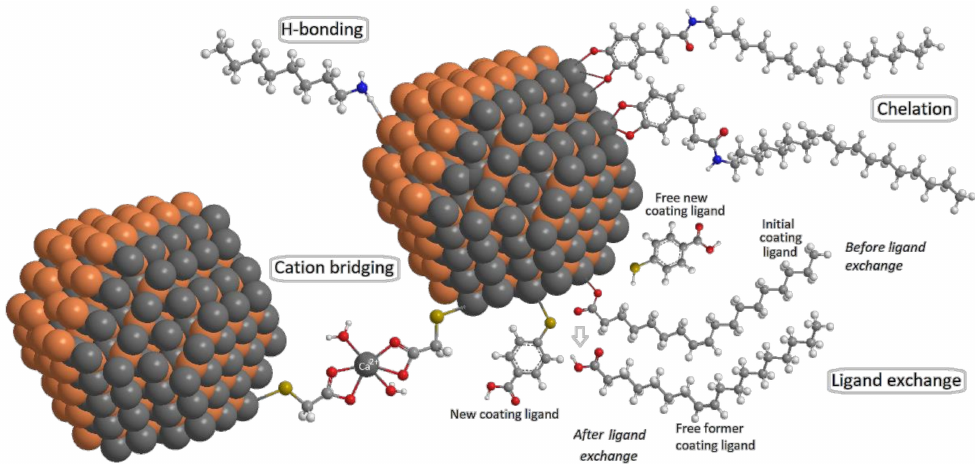
Figure 3. Schematic diagram to illustrate the bonding forms for main adsorption modes of dissolved ligands onto the surface of CdSe QDs (Cd: grey balls; Se: brown balls). Left top: CdSe-octylamine has been used here as an illustrative example of an H-bonding interaction. Right top: The interaction between CdSe and a catechol-based oleylamine shows a couple of modes of chelation. Right-bottom: The desorption of oleic acid from coated QDs and the subsequent absorption of 4-mercaptobenzoic acid illustrates the ligand exchange mode. Left-bottom: The interaction between thioglycolate-capped QDs and Ca 2+ shows cation bridging mode among